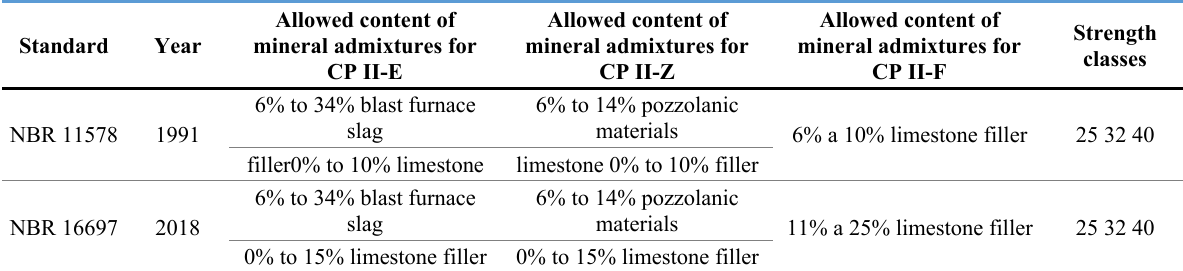
Table 5. Evolution of standardisation of Portland-composite cement (CP II) in Brazil, in terms of maximum clinker + calcium sulphate replacement in